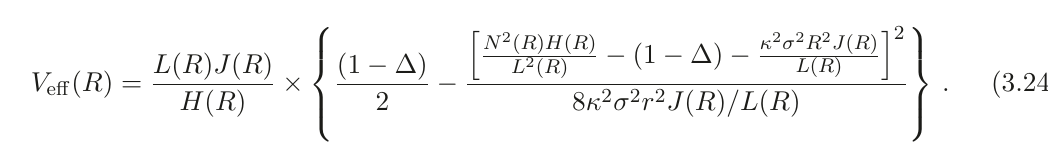
(a) Potential turning points R 0 and R 1 for κ =0, ǫ = 0 . 005. Figure 5. Effective potential for Φ = 100, ǫ = 0 . 005 and several values of the gravitational coupling constant κ